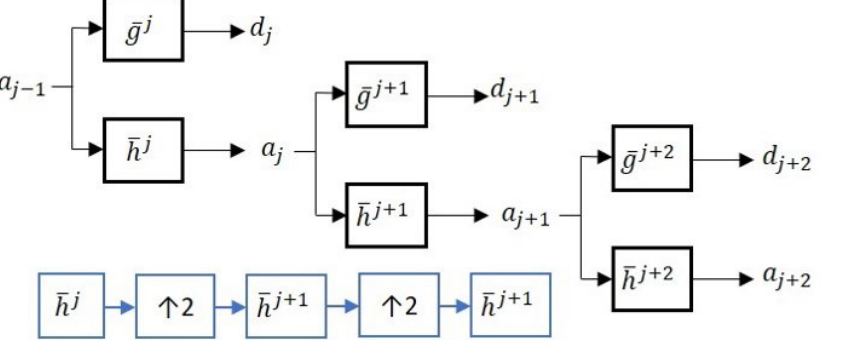
Figure 2. Schematic diagram of the undecimated wavelet transform (UWT); h and g are high- and low-pass filters; a and d represent the approximate and detail signals.